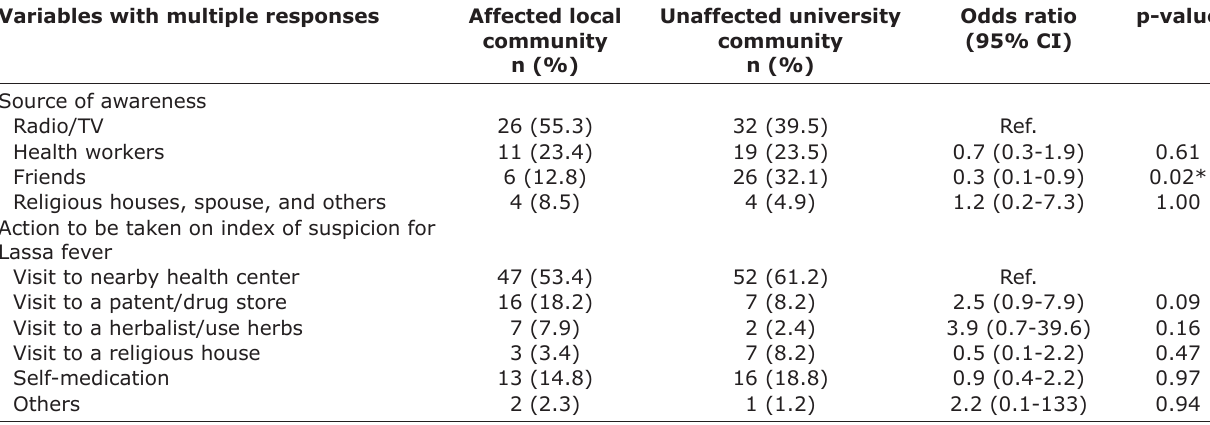
Table-3: Bivariate analysis of source of awareness and what action will be taken in case of index of suspicion for Lassa fever among respondents in affected local and unaffected university communities, Ibadan, Nigeria 2012. Variables with multiple